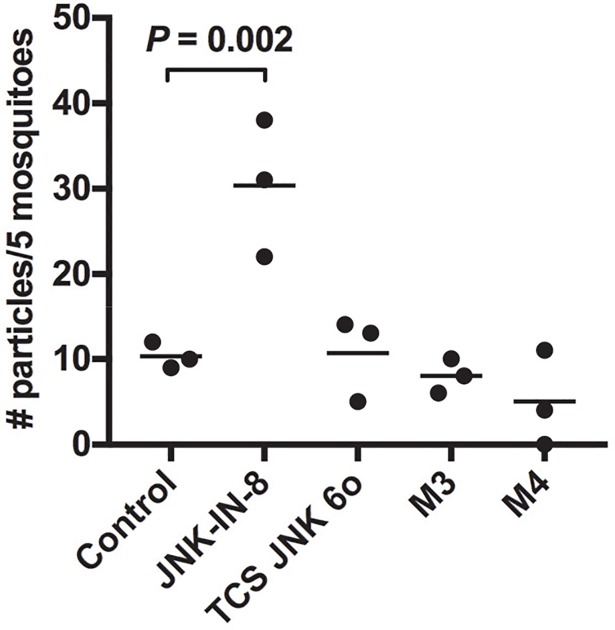
Midgut permeability was inconsistently altered by treatment with JNK SMIs and unaffected by midgut MKP4 overexpression.Non-transgenic (control) A. stephensi (3–5 day old) were fed on artificial blood meals containing 2.0–2.4 μm magnetic fluorescent particles (Spherotech) with or without supplementation with 1 μM JNK-IN-8 or 1 μM TCS JNK 6o. Particle numbers were quantified at 72 h post-blood feeding as described in the methods. Dots represent particle numbers per five mosquitoes and bars indicate the means. Data were analyzed by one-way ANOVA.